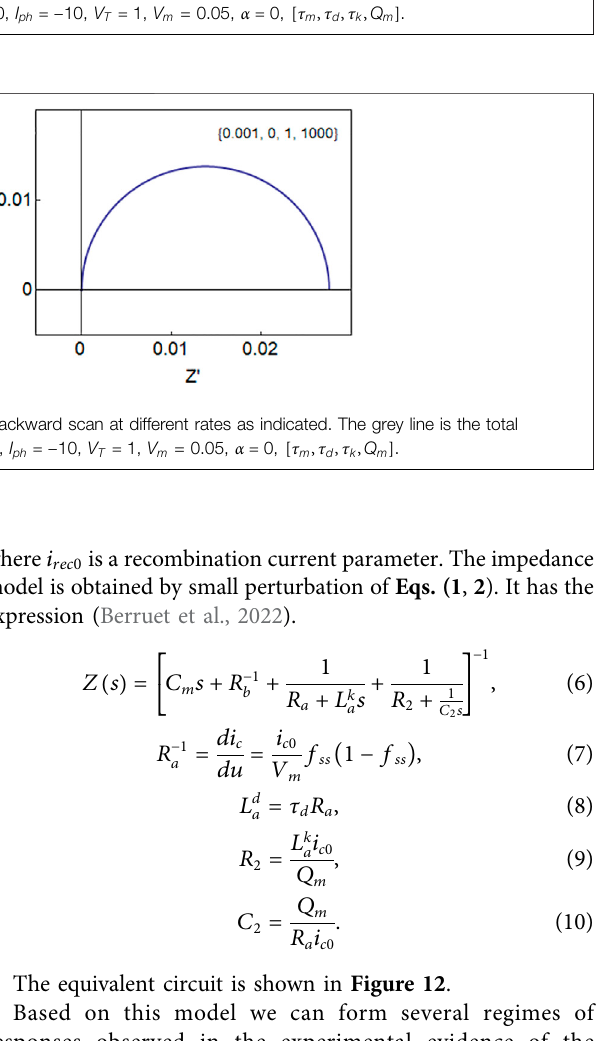
Frontiers in Energy Research |